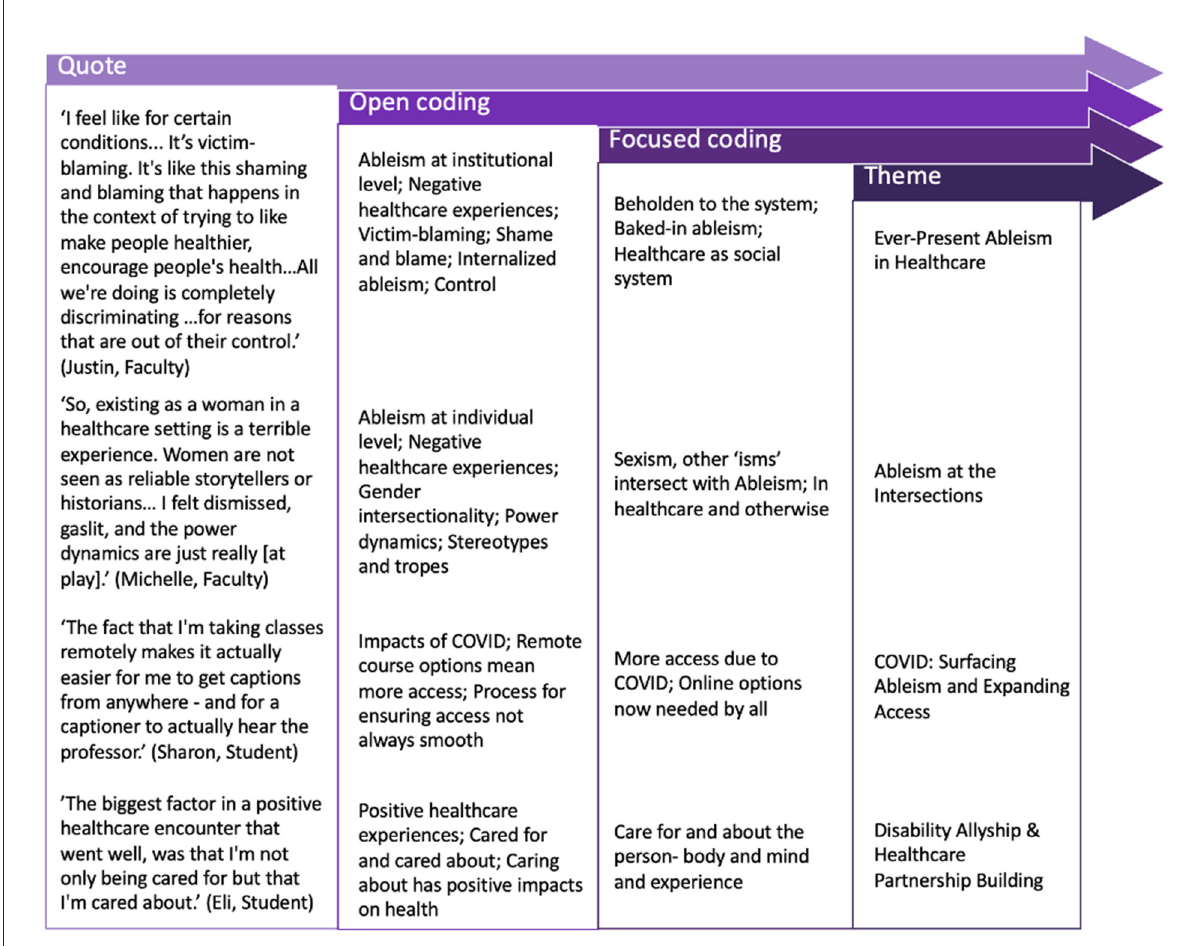
FIGURE2 Diagram of three-step coding process showing how individual participant quotes were categorized through open coding, then focused coding, and finally aggregated into four dominant themes. Four example quotes are provided listing each quote’s open coded category, focused coded category, and respective